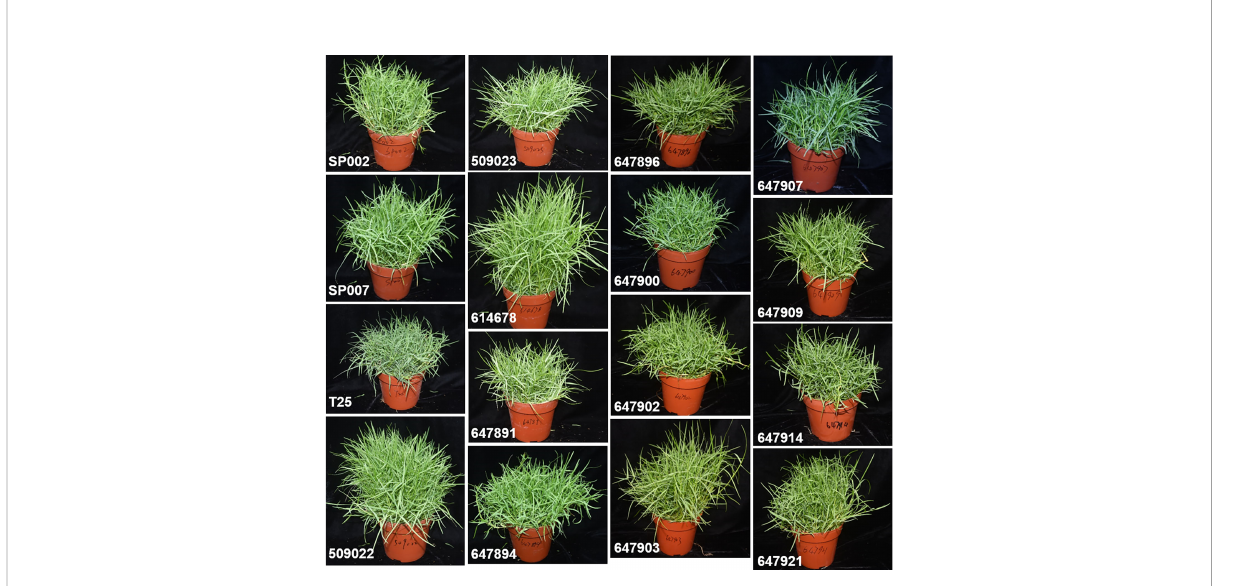
FIGURE 1 Characterization of 16 seashore paspalum ecotypes under normal condition for 40